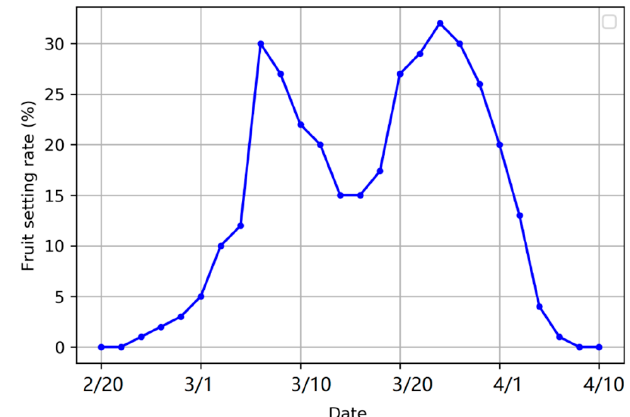
Figure 2. Simulated frequency distribution of strawberry fruiting dates in simulation and practical greenhouse planting. The X -axis represents the planting date. The Y -axis represents the corresponding flower quantity ( A ) and real fruit setting rate ( B ).